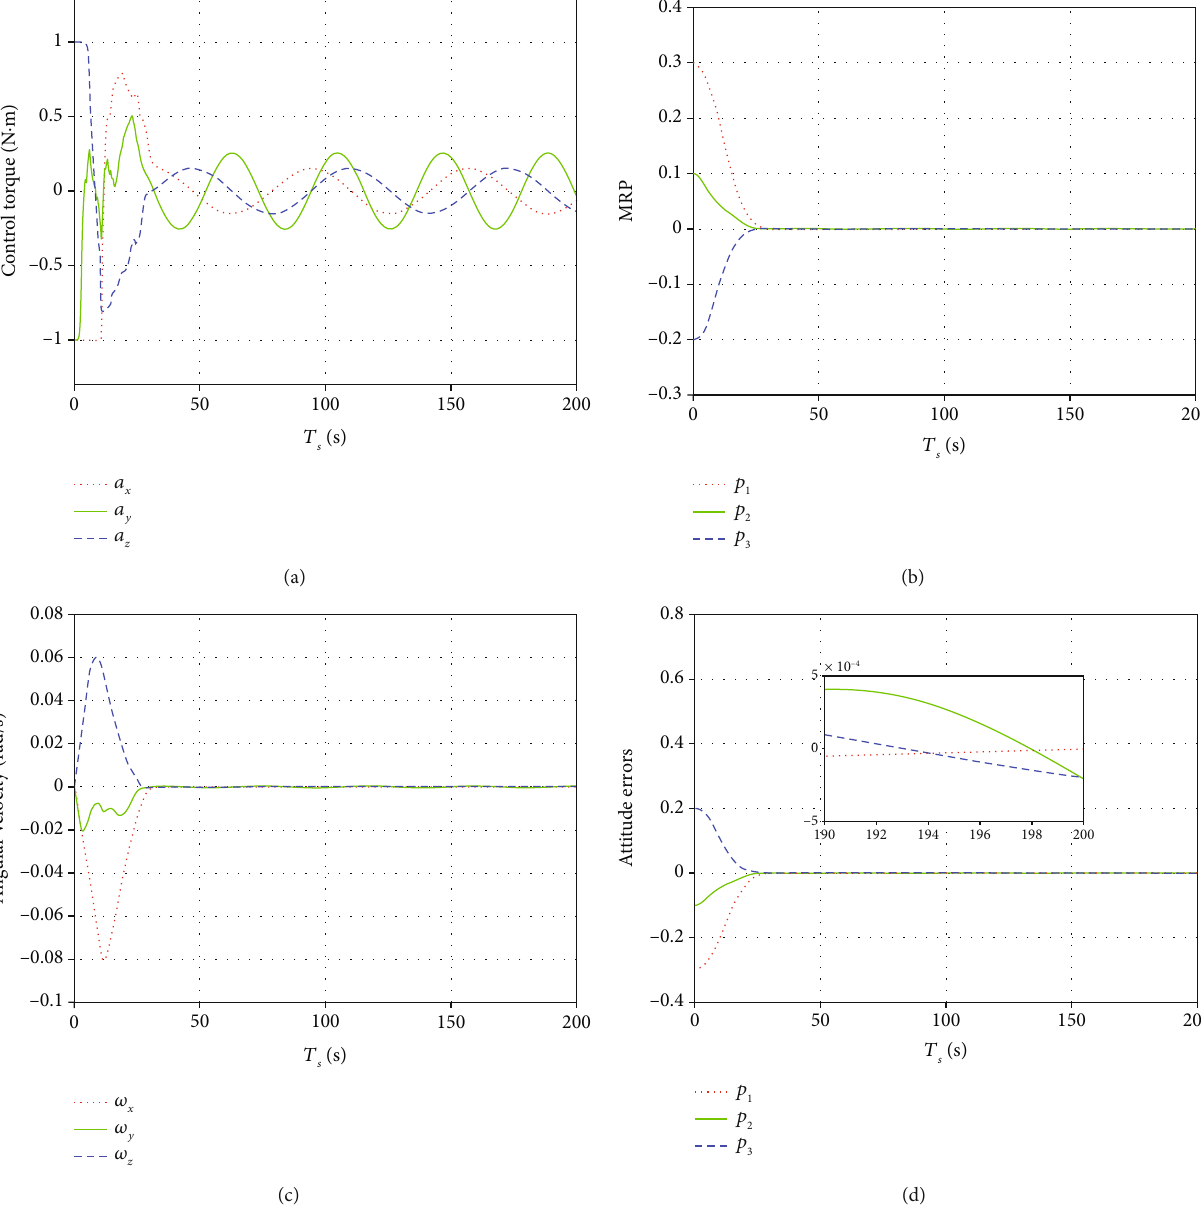
Figure 11: Attitude stabilization using the PID-Guide TD3 algorithm under unknown external disturbances: (a) time response of control torque; (b) time response of MRP; (c) time response of angular velocity; (d) the attitude error